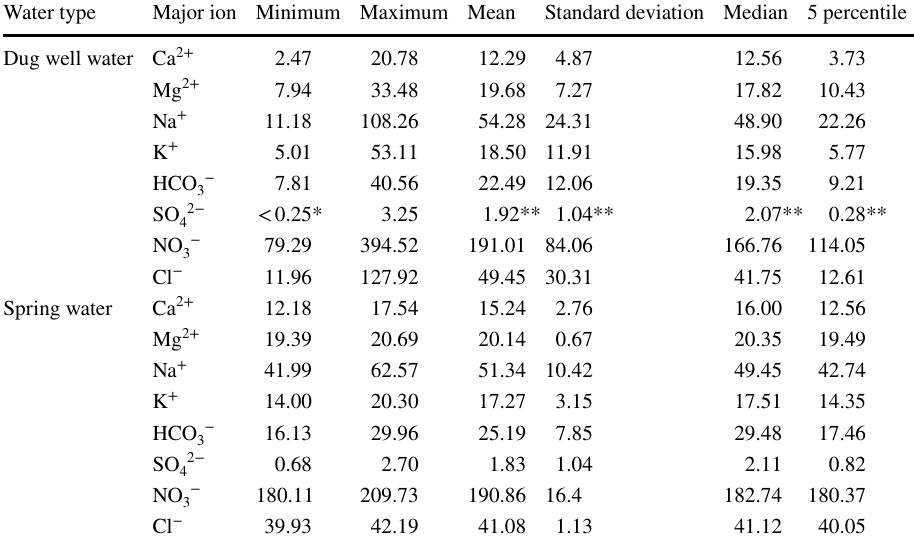
Table 1 Statistical summary of the hydrochemical data of the dug well waters and the spring waters in the study area